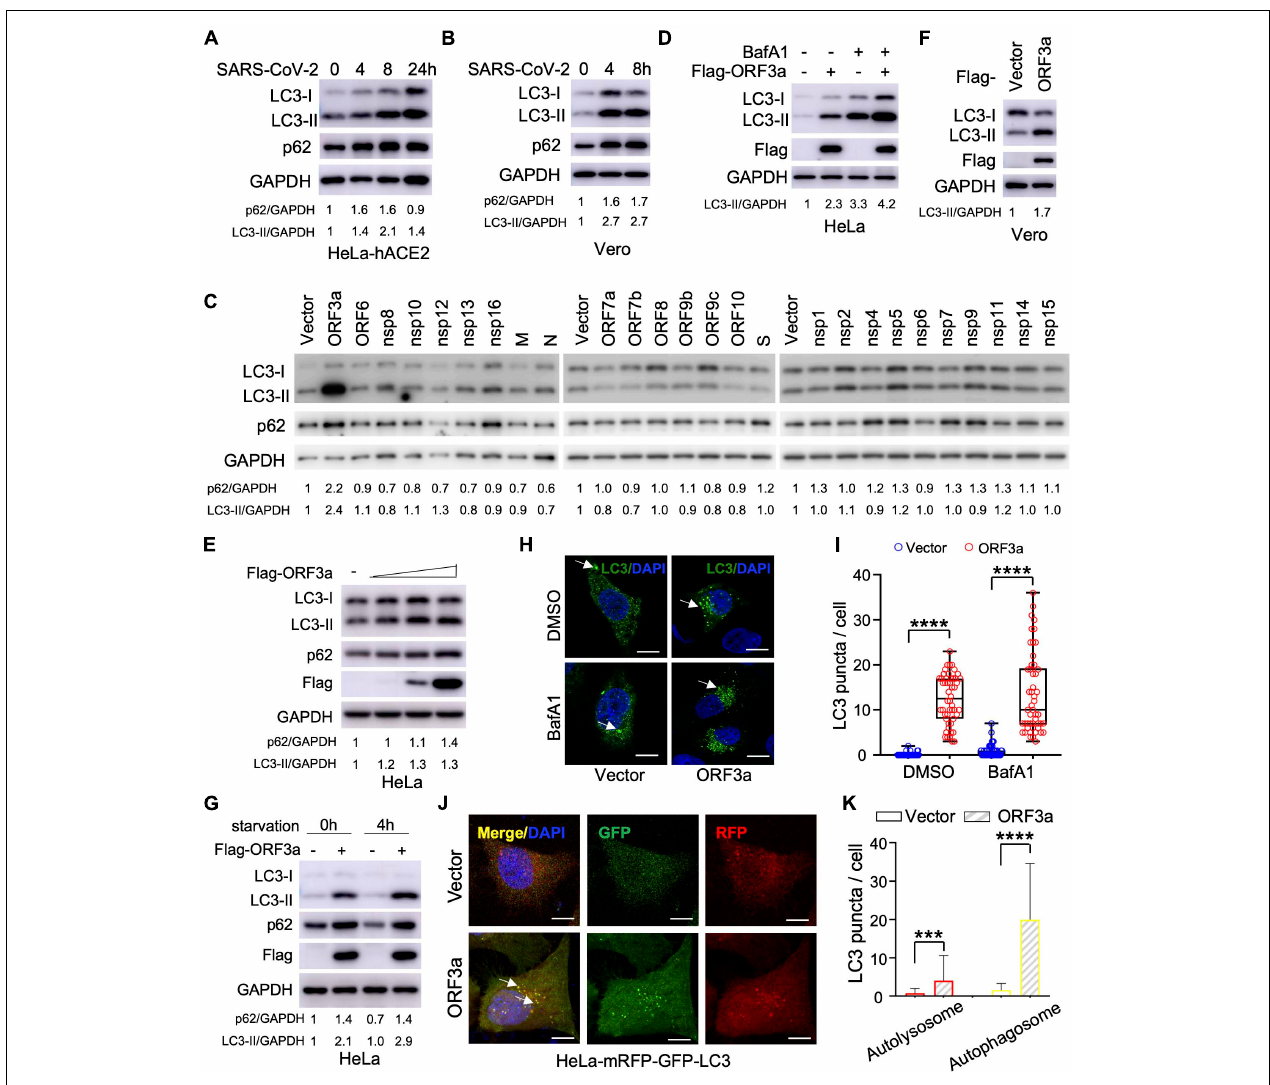
FIGURE 1 | Severe Acute Respiratory Syndrome Coronavirus-2 (SARS-CoV-2) ORF3a triggers incomplete autophagy. (A–B) SARS-CoV-2 infection triggers incomplete autophagy. HeLa-hACE2 (A) or Vero-E6 (B) cells were infected with SARS-CoV-2 (MOI = 1) and cell lysates were collected at indicated time point post-infection for immunoblotting (IB) with indicated antibodies. (C) Screening of SARS-CoV-2-encoded proteins for LC3-I to LC3-II conversion in HeLa cells. (D,E) SARS-CoV-2 ORF3a induces incomplete autophagy. HeLa-vector and HeLa-ORF3a stable cells were treated with or without BafA1 (100 nM) for 4 h and the cell lysates were collected for IB with indicated antibodies (D) . HeLa cells were transfected with increasing amount ORF3a expressing plasmid and the cell lysates were collected for IB with indicated antibodies at 48 post-transfection (E) . (F) ORF3a expression modulates autophagy in Vero-E6 cells. (G) ORF3a blocks SQSTM1/p62 degradation upon starvation. HeLa-vector or HeLa-ORF3a stable cells were treated by serum starvation for 4 h and the cell lysates were collected for IB with indicated antibodies. (H,I) SARS-CoV-2 ORF3a induces LC3 puncta formation. HeLa-vector or HeLa-ORF3a cell line were treated with BafA1 (100 nM) and endogenous LC3 puncta were immunostained (H) and quantified (I) . Scale bar, 15 µ m. Arrow: representative autophagosomes. (J,K) HeLa-mRFP-GFP-LC3 stable cells were transfected with ORF3a or vector control and transfected cells were fixed and the LC3 puncta were captured (J,K) quantified as indicated. Yellow puncta, autophagosomes; Red puncta, autolysosomes; Arrow, representative autophagosomes. p62/GAPDH or LC3-II/GAPDH levels were quantified by the band intensity in (A–G) . Similar results were obtained by three independent experiments. Mean ± SEM; n = 50; *** p < 0.001 and **** p < 0.0001 by Student’s t test in panels (I,K)